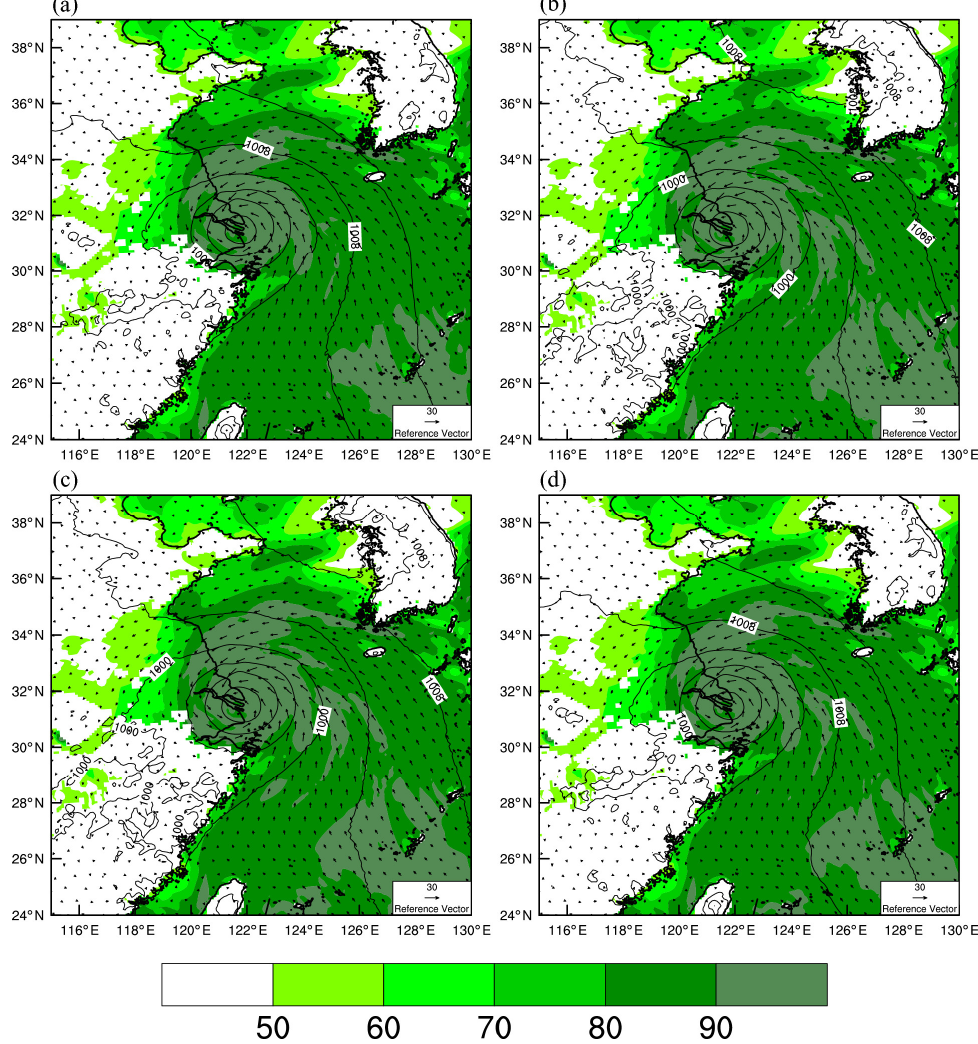
Figure 5. Sea level pressure (hPa), 10 m wind speed (m/s), and 100 m relative humidity (%) of ( a ) AMSU experiment, ( b ) MHS experiment, ( c ) MWHS experiment, ( d ) ALL experiment at 0600UTC on 22 July 2018.